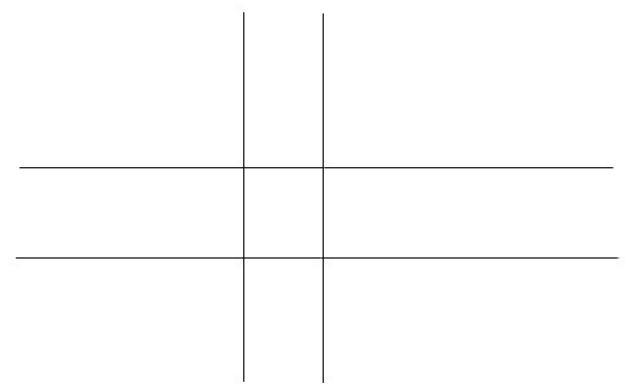
Figure 4 - Crossroads as two intersecting roads DOI: https://doi.org/10.18454/RULB.2023.38.6.5